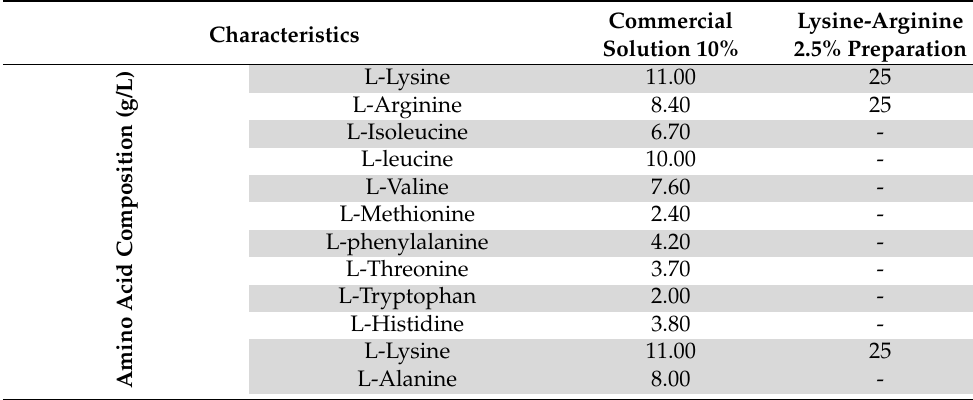
Table 1. Composition of the two